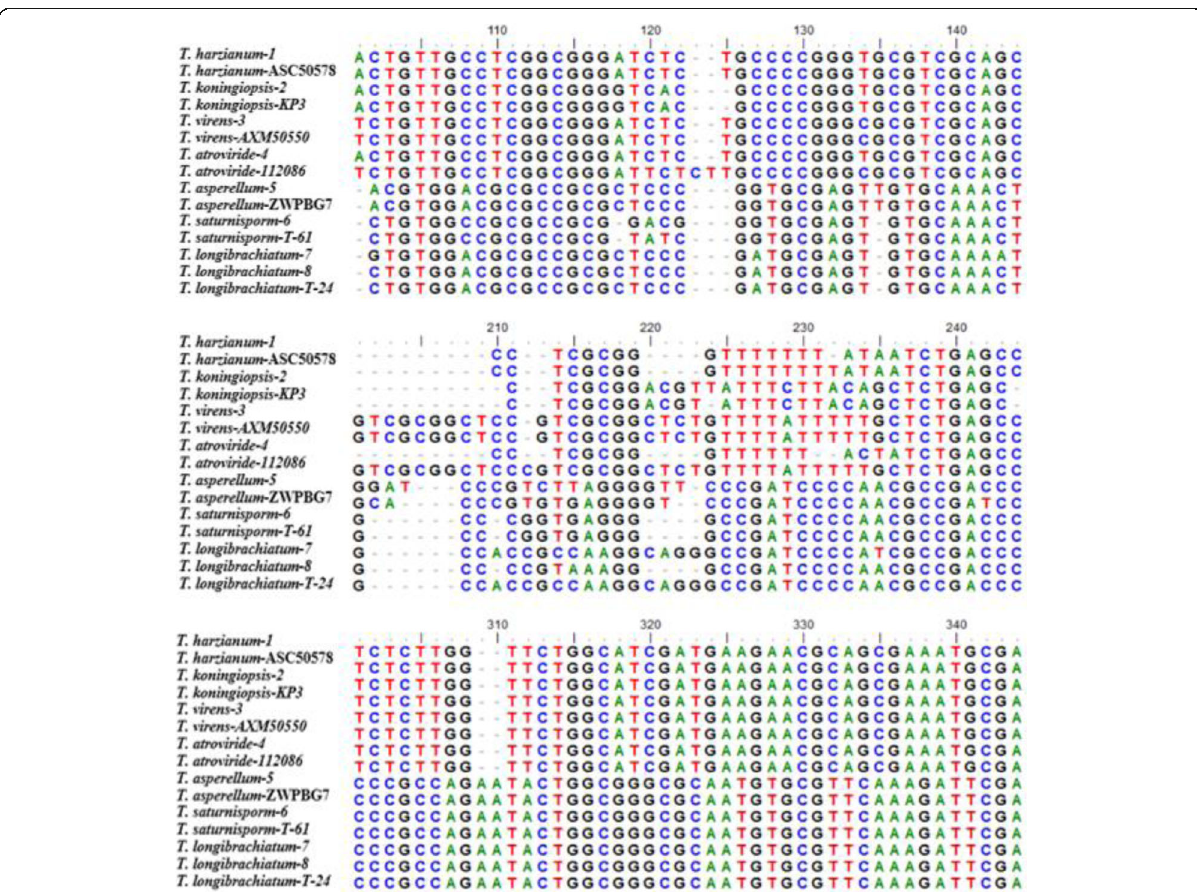
Fig. 1 Multiple alignment of the ITS nucleotide sequences of eight Trichoderma strains. The alignment was achieved among eight Trichoderma strains and related sequences of some Trichoderma strains in the GenBank database, using the BioEdit